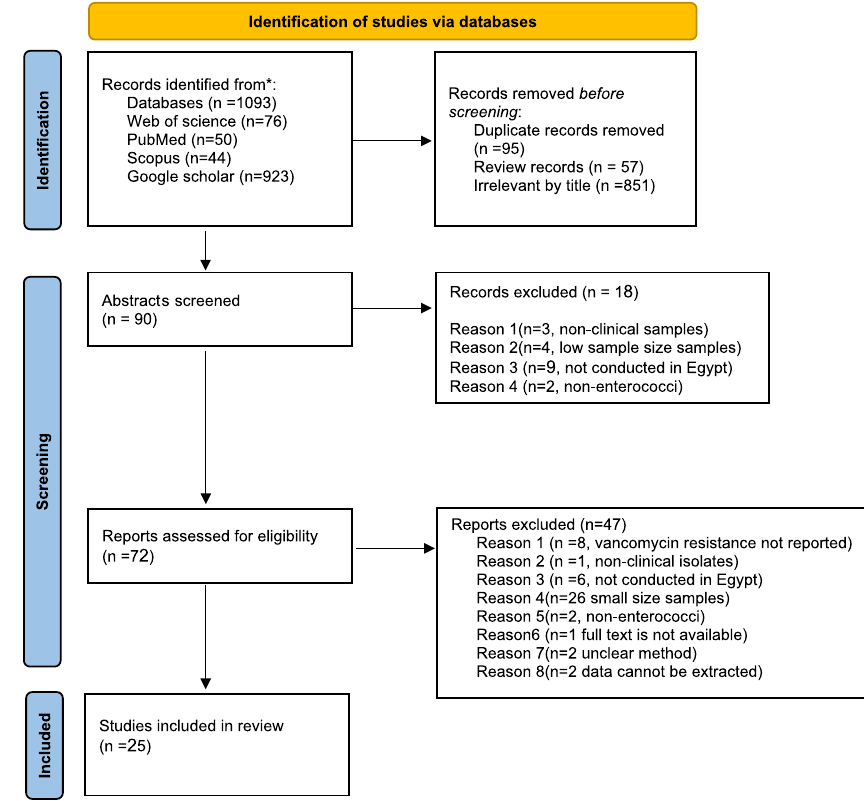
Fig. 1 Flow chart depicting the selection of